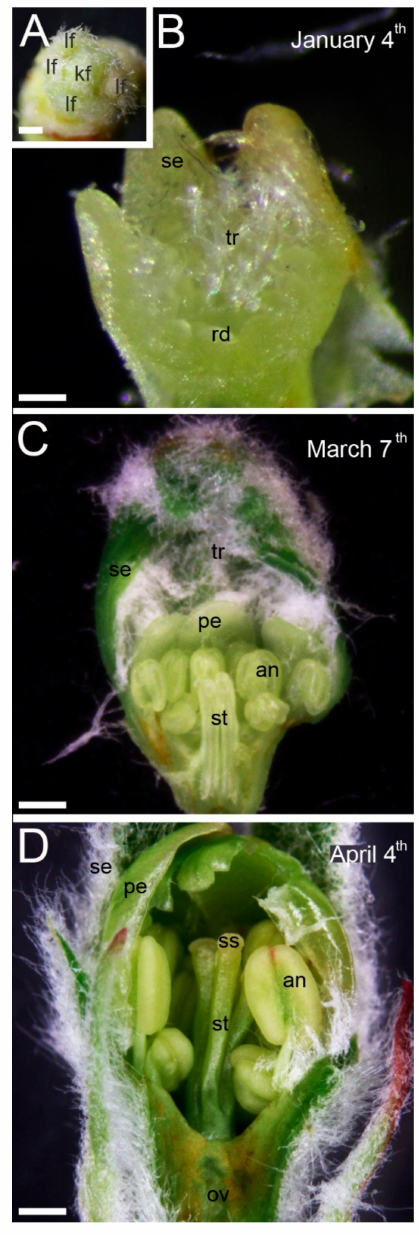
Figure 4. Flower development and growth during dormancy until bud burst. ( A ): Apple cyme during winter (4th of January 2019); ( B ): King flower primordia presenting sepals with numerous trichomes and undi ff erentiated flower verticiles during winter (4th of January 2019); ( C ): Distinguishable stamens and pistils at the end of winter (7th of March 2019); and ( D ): Anthers with yellowish appearance and stigmas at the end of the styles (4th of April 2019). Abbreviations: lateral flower (lf), king flower (kf), sepals (se), trichomes (tr), rounded dome (rd), petals (pe), anthers (an), style (st), stigma (ss), and ovary (ov). Scale bars: A, C, and D = 500 µ m; B = 100 µ